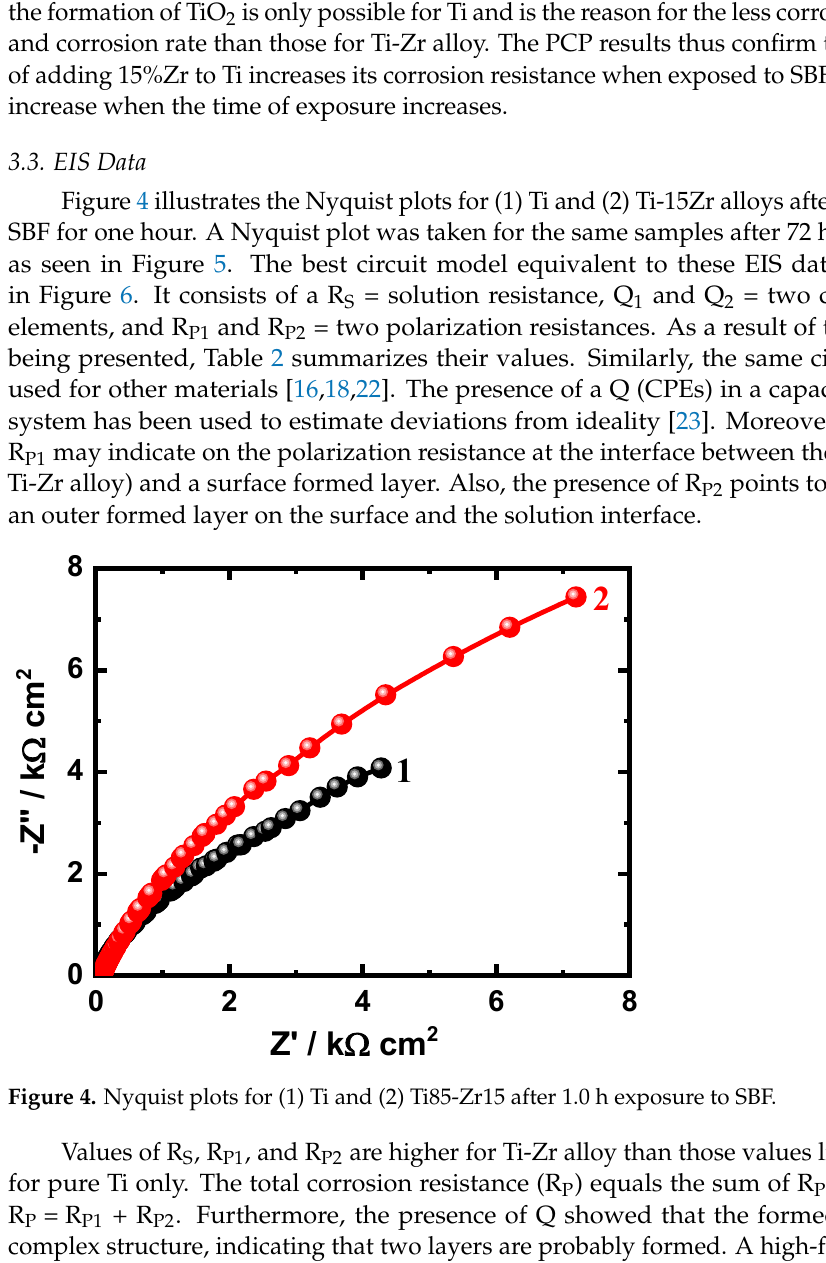
Figure 5. Nyquist plots for (1) Ti and (2) Ti85-Zr15 after 72 h exposure to SBF. Values of R S , R P1 , and R P2 are higher for Ti-Zr alloy than those values listed in Table 2 for pure Ti only. The total corrosion resistance (R P ) equals the sum of R P1 , and R P2 , i.e., R P = R P1 + R P2 . Furthermore, the presence of Q showed that the formed films have a com- plex structure, indicating that two layers are probably formed. A high-frequency inner layer is characterized by dominant impedance, while a low-frequency outer layer is po- rous and characterized by dominant impedance [24–29]. The Q 1 and Q 2 , with the values of their “n”, are assigned the role of a double-layer capacitor, C dl , which confirms the ex- istence of pores on the outer layer. Those C dls signify that Zr increases the passivity of the Ti in SBF solution. Table 2 also proves that the values of Y Q1 and Y Q2 decrease in the pres- ence of Zr, indicating also that Zr increases the passivity of the Ti. This effect of increasing the surface and polarization resistances and the decreasing of the constant phase elements increases when exposure time in SBF increases from 1 h to 72 h.